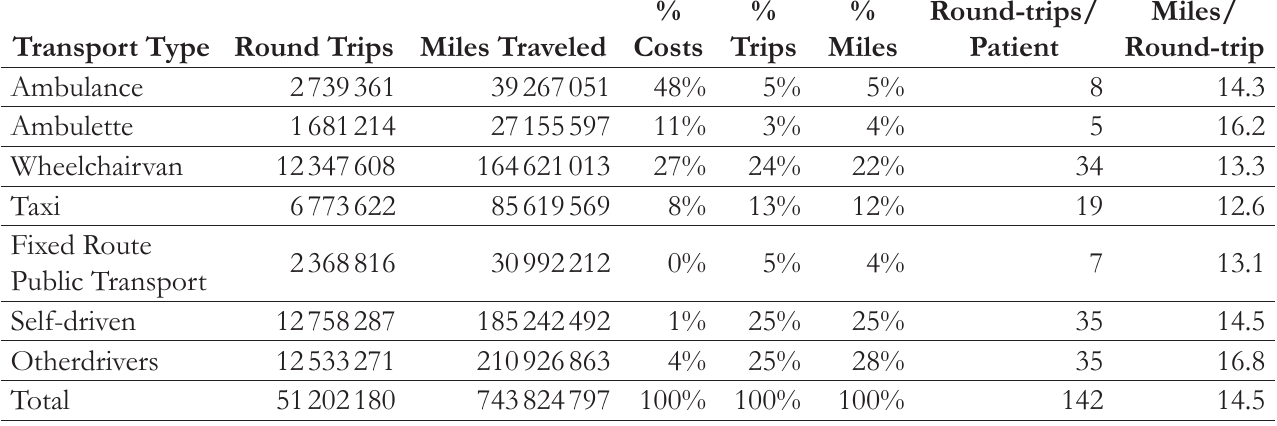
Table 6. 2012 National Utilization Statistics - Transportation to In-Center Dialysis Transport Type Round Trips